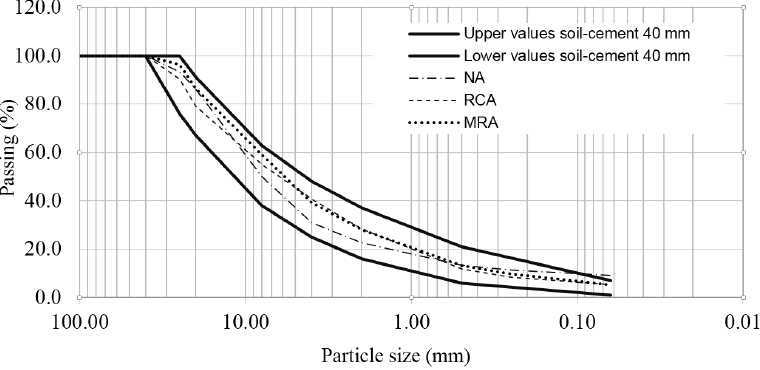
Figure 1. Particle size distribution curves of NA, RCA and MRA, compared with the granulometric limits.